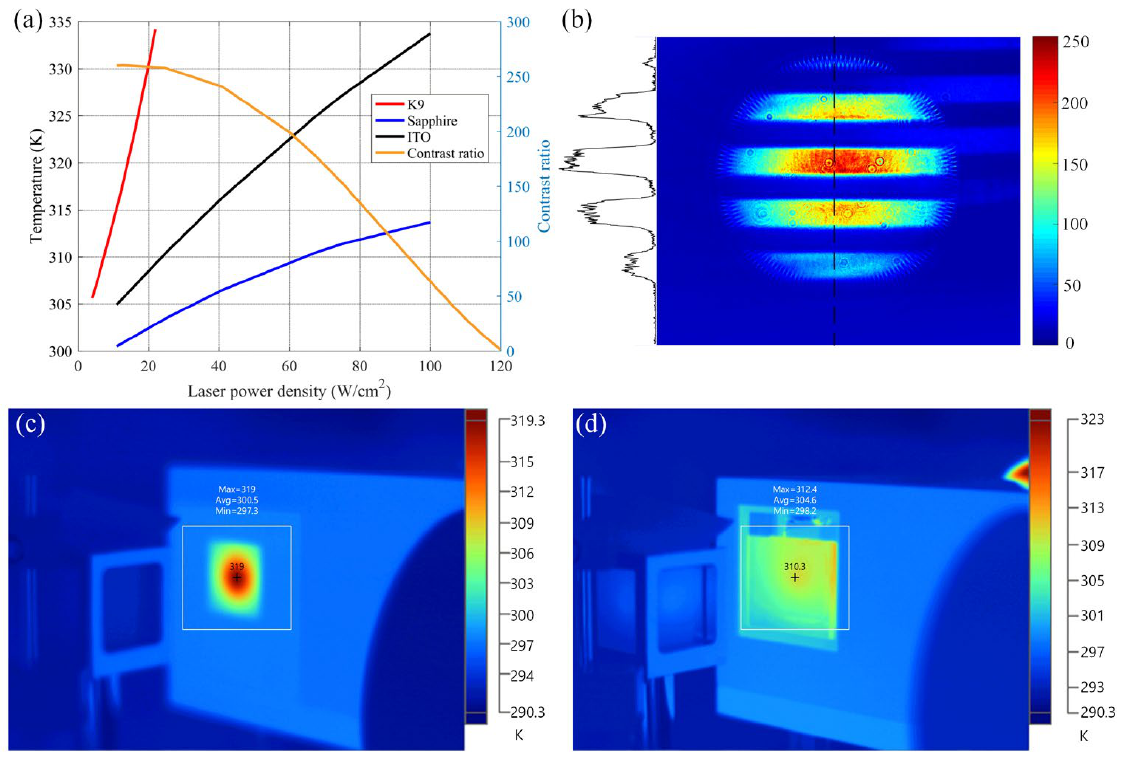
Figure 8. ( a ) The substrate surface temperature of K9 and sapphire OASLM device as a function of laser power density and the contrast ratio of sapphire OASLM changes with power intensity. ( b ) Light field distribution of sapphire OASLM output at 75 W/cm 2 . ( c ) Thermal image of OASLM based on K9 substrate at 10 W/cm 2 laser intensity. ( d ) Thermal image of OASLM based on sapphire sub- strate at 75 W/cm 2 laser intensity.